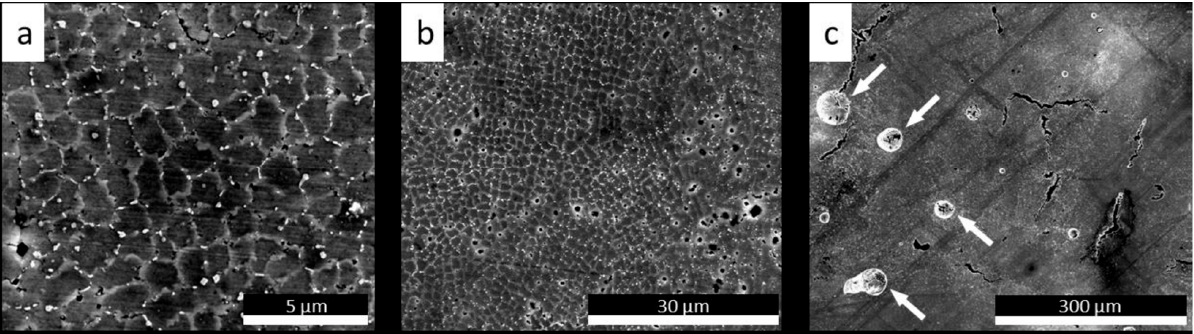
Figure 2. SEM images showing the microstructures of the LPBF Inconel 939 with different magnifi- cations. ( a ) grain structure ( b ) the distribution of defects within the grain structure ( c ) morphology of the cracks and the pores.